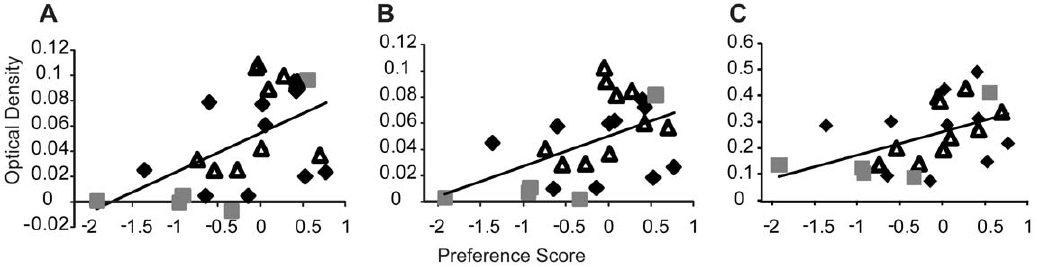
Figure 3. Individual variation of preference score and neuroserpin expression. Significant correlations between individual variation in preference score and neuroserpin expression in (a) Dm, (b) Dl, and (c) POA. Triangles, diamonds, and squares represent LL, LS, and SS exposed females, respectively.